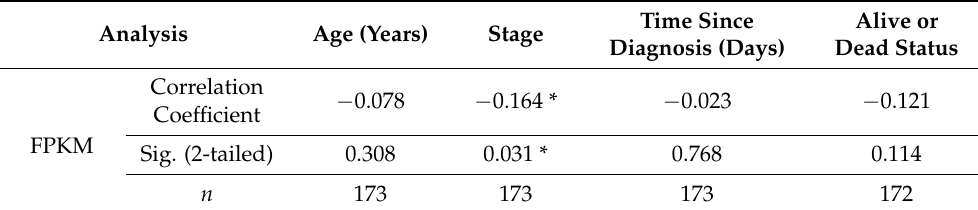
Table 3. Correlation between the expression of FPKM and patient’s age, stage, time since diagnosis and status for 173 pancreatic ductal adenocarcinoma patients, using Spearman’s rank correlation coefficient. Significance was observed between FPKM expression and cancer stage. * value is statistically